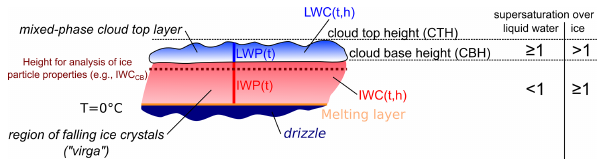
Figure 1. Schematic representation of the different measurement and averaging schemes in a mixed-phase cloud layer. Water droplets within the mixed-phase top layer are detected by lidar. The ice pre- cipitation below is mainly detected by the cloud radar. IWC and LWC are provided by Cloudnet and are a function of height ( h ) and time ( t ). IWP and LWP are the column integrated values of LWC and IWC over the liquid cloud top and the ice precipitation respectively. IWC CB represents the mean of all IWC values mea- sured about 60m below current cloud-base height (CBH). Follow- ing Zhang et al. (2014), state of water saturation is indicated for the different parts of the clouds.